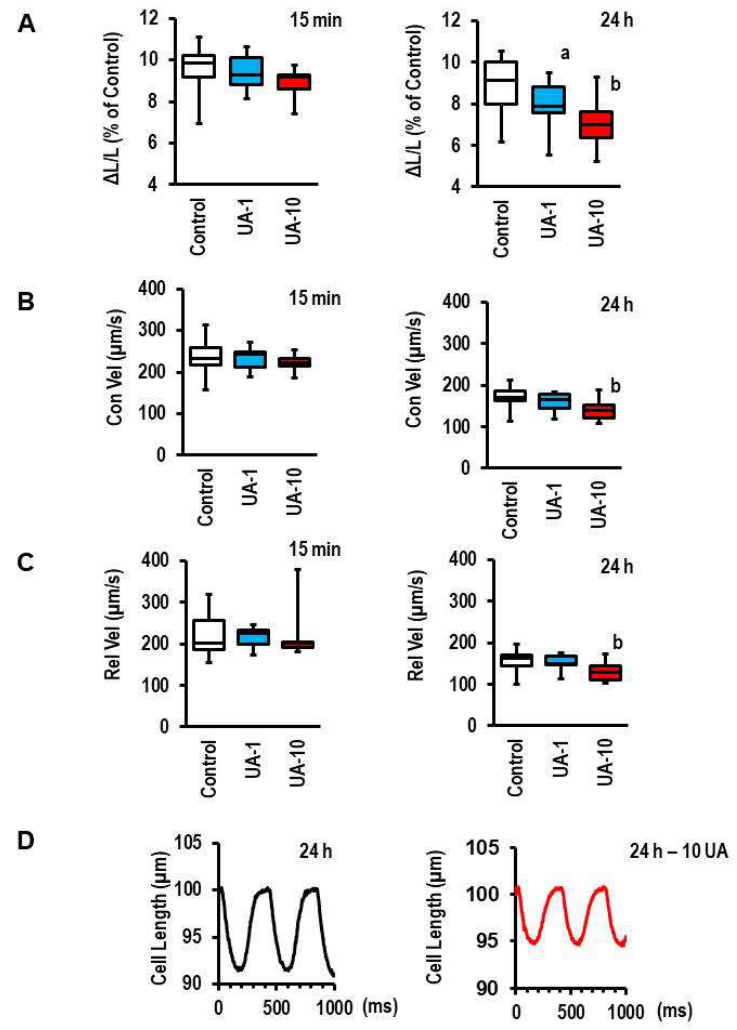
Figure 1. Effect of uric acid (UA) on cell shortening of cardiomyocytes. Cells were treated with UA for 15 min or 24 h, as indicated. Concentrations used were 1 mg/dl (UA-1) or 10 mg/dl (UA-10). Data show results for relative cell shortening (shortening amplitude [ Δ L] normalized to diastolic cell length [L] and expressed as percent cell shortening ( A ), contraction velocity (Con-Vel, ( B )) expressed in µm per s, and relaxation velocity (Rel-Vel, ( C )) expressed in µm per s. Representative single-cell recordings for 24 h UA exposure (10 mg/dl) are given in ( D ). Data are means from n = 11 (control, 10 min), n = 10 (UA-1, 10 min), n = 6 (UA-10, 10 min), n = 24 (control, 24 h), n = 13 (UA-1, 24 h), and n = 22 (UA-10, 24 h) preparations (rats), with 4 cell culture dishes per preparation and 9 cells evalu- ated per cell-culture dish. Statistical analysis is based on preparations. Data are expressed as bars and whiskers with median, 25% quartile, 75% quartile indicated by bars, and complete range by whiskers. Statistical analysis is based on one-way ANOVA and Student – Newman – Keuls post hoc analysis. a, p < 0.05 vs. control and UA-10; b, p < 0.05 vs. control and UA-1. 3.2. Effect of UA on Arginine Metabolism As UA effects on the load-free cell shortening of cardiomyocytes required long-term exposure, this favored transcriptional modifications as a mechanistic explanation. Argi- nine metabolism has multiple connections to UA effects in other cells, as mentioned in the